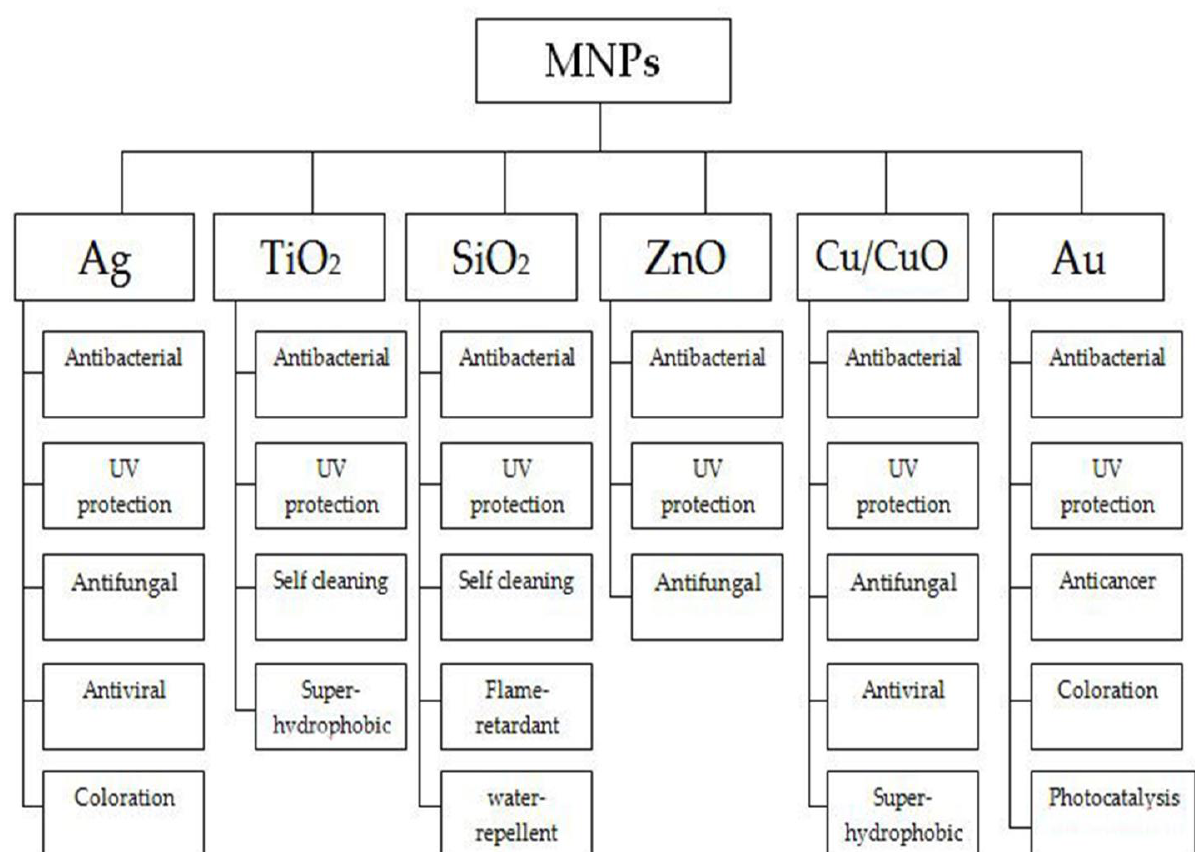
Figure 1. Metal nanoparticles and their functions used in textiles.